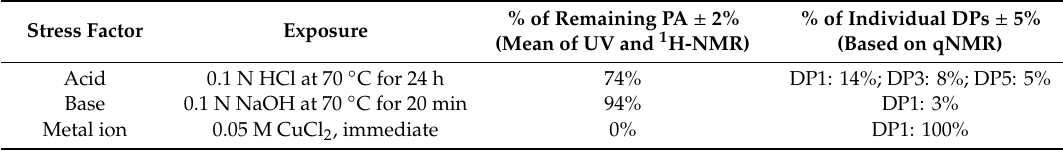
Table 2. Summary of indapamide degradation behavior.